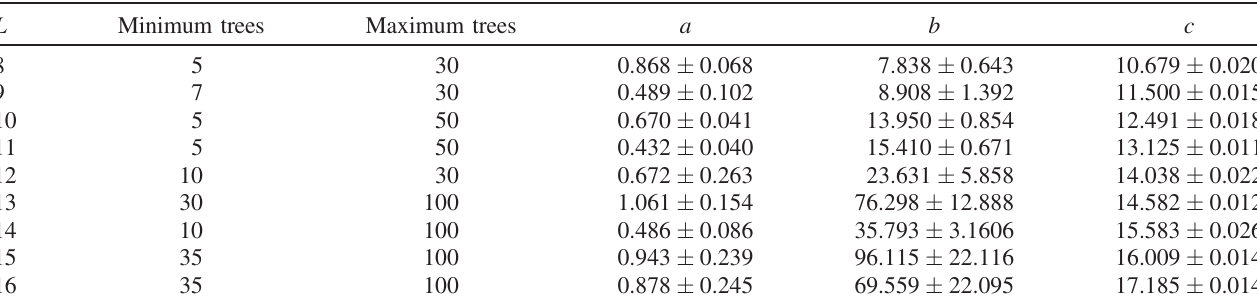
TABLE V. Fit to ax − 3 þ bx þ c − 4 ð a 3 b Þ 1 = 4 = 3 3 = 4 for the median results of the hardware-planted instances using HFS with y ¼ log TTS and x ¼ log n . The factor c does not include τ trees